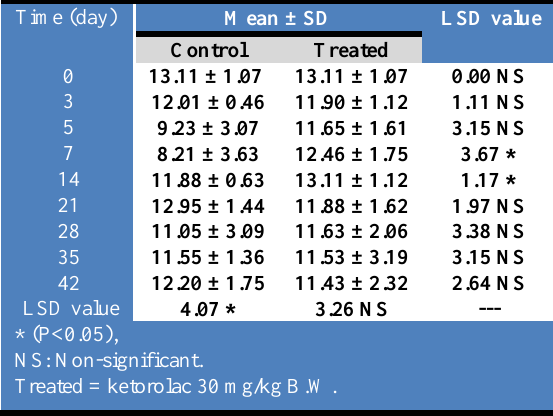
Table, 2: Shows Hb concentration (g/dl) in control and ketorolac treated rabbits.